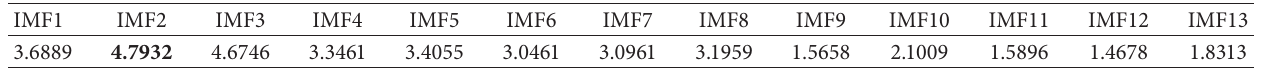
Table 4: Kurtosis of EEMD components.